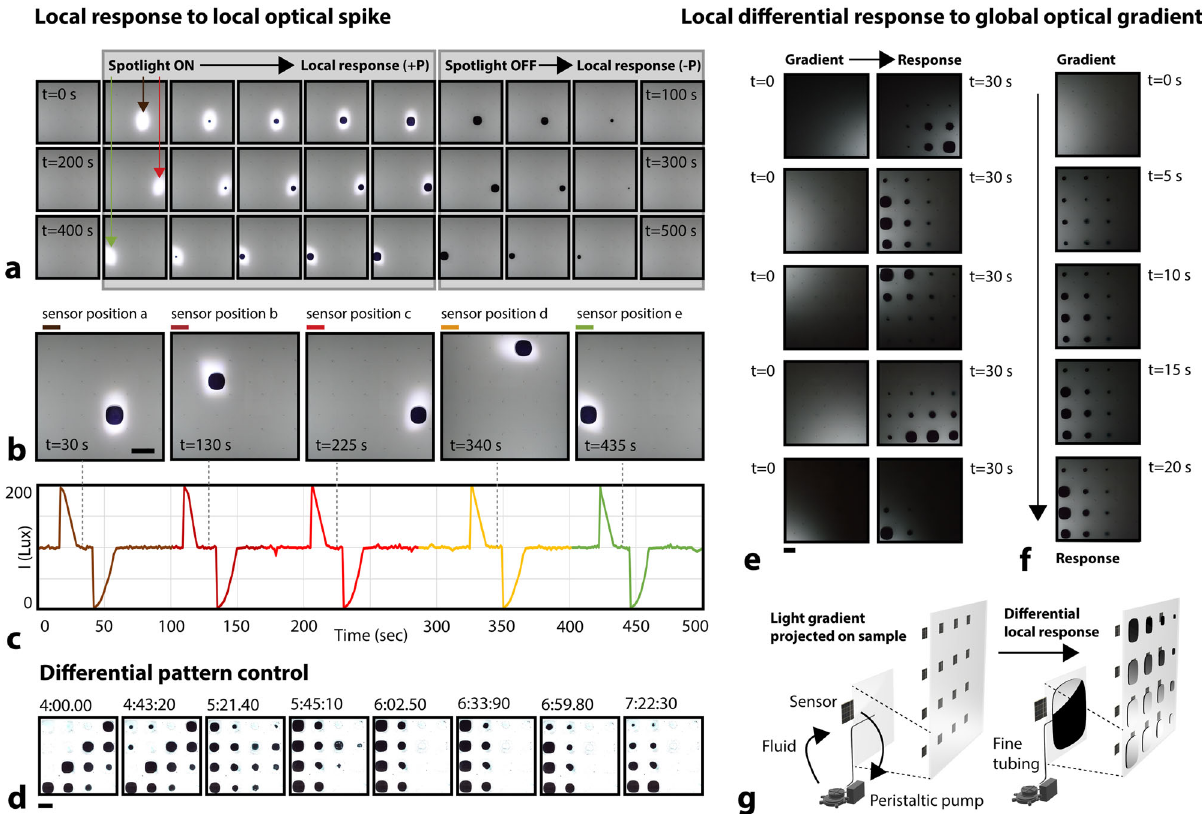
Fig. 4 Differential pigment responsiveness. a Independent sequential pigment fl uid dispersal/retraction cycles as a response to measured local light intensity behind each cell. Measured value of light intensity drives negative feedback response for each digitally-driven pump. b Image captures from Supplementary Movie 5, showing localized responses in fi ve independent positions across the facade over time. Scale bars are 10 cm. c Light intensity as a function of time for fi ve different sensors. d Image captures from Supplementary Movie 6 to demonstrate differential pattern control over time. Scale bar is 10 cm. e Differential pigment fl uid response across all sixteen cells for fi ve independent sequences. Scale bar is 7 cm. f Second sequence from ( e ). g Schematic of experiment in ( e , f